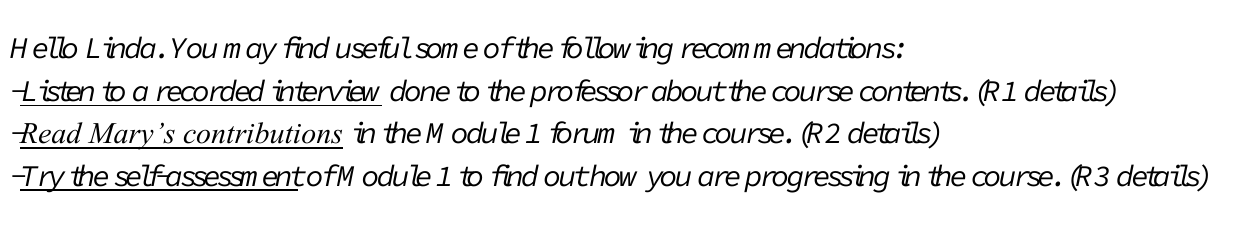
Figure 2. Example of a recommendation